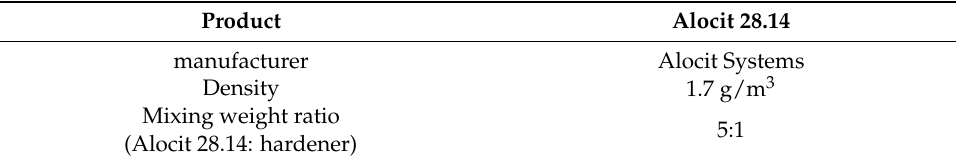
Table 1. Information/Material Properties of the coating